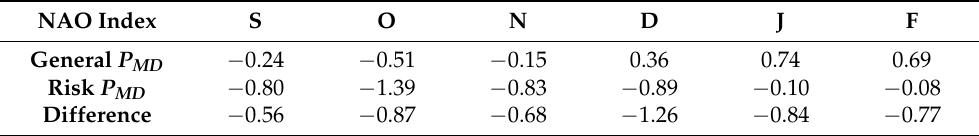
Table 4. Effect of monthly NAO index (September to February) on the daily precipitation level. NAO Index S O N D J F General P MD −